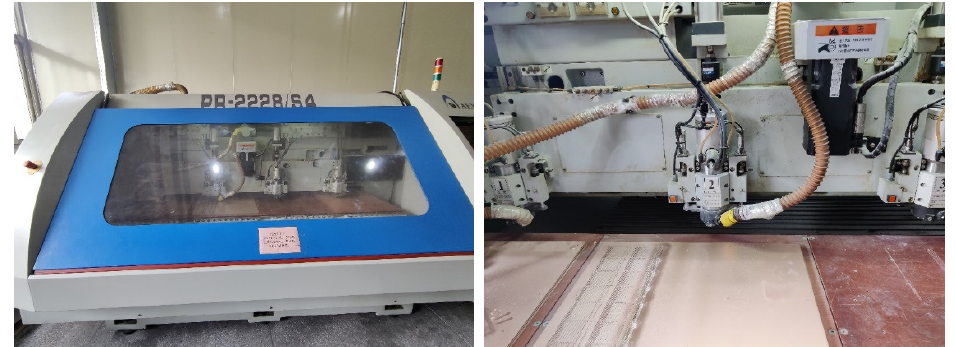
Table 3. Milling experiment parameters.